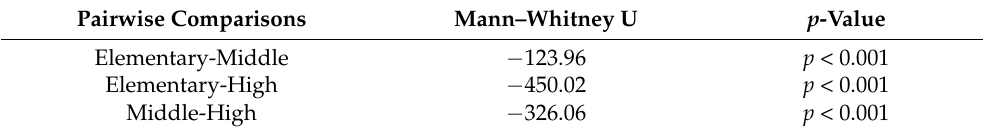
Table 2. Pairwise comparisons among elementary, middle and high school students.